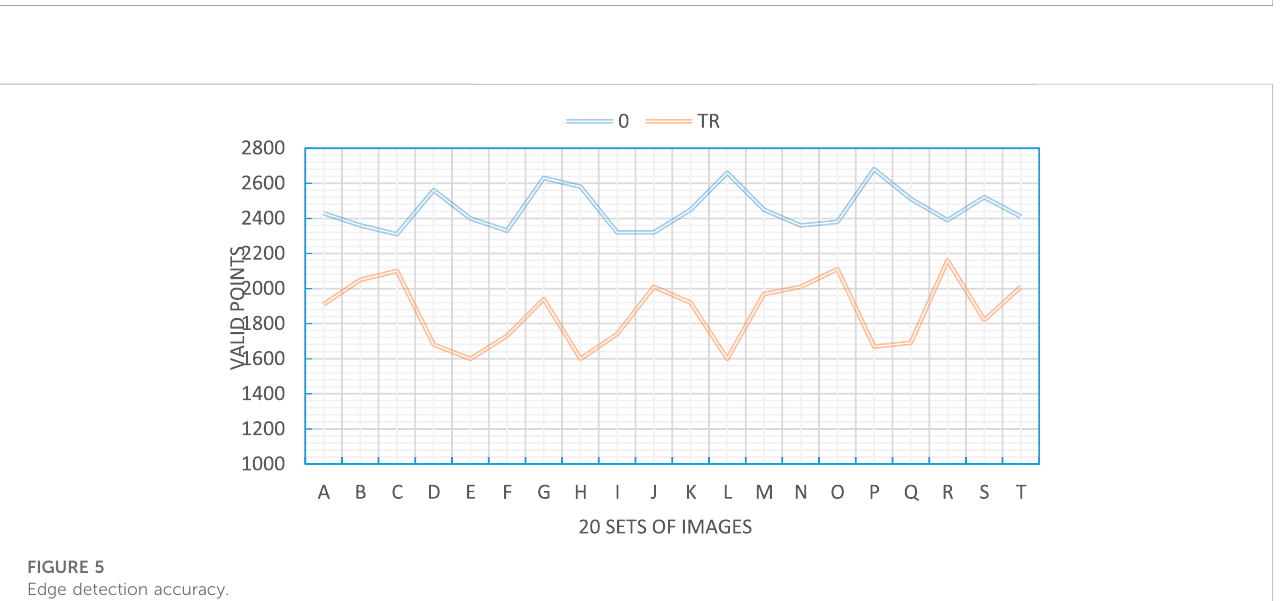
FIGURE 5 Edge detection